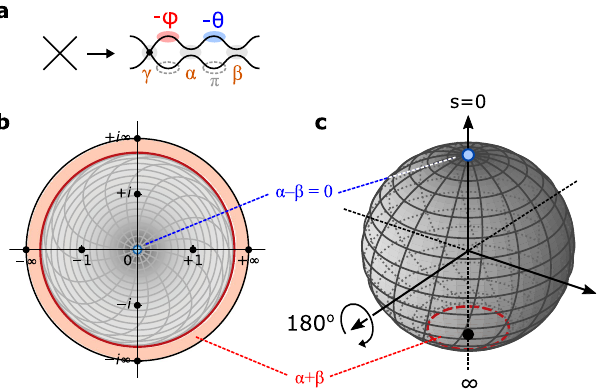
Fig. 5 | MZI+crossing architecture.a SchematicofMZI+X. b Effectof the crossing is to fl ip the s =0 and s = ∞ forbidden regions. For correlated errors, the forbidden region around s =0 disappears. c Riemann sphere